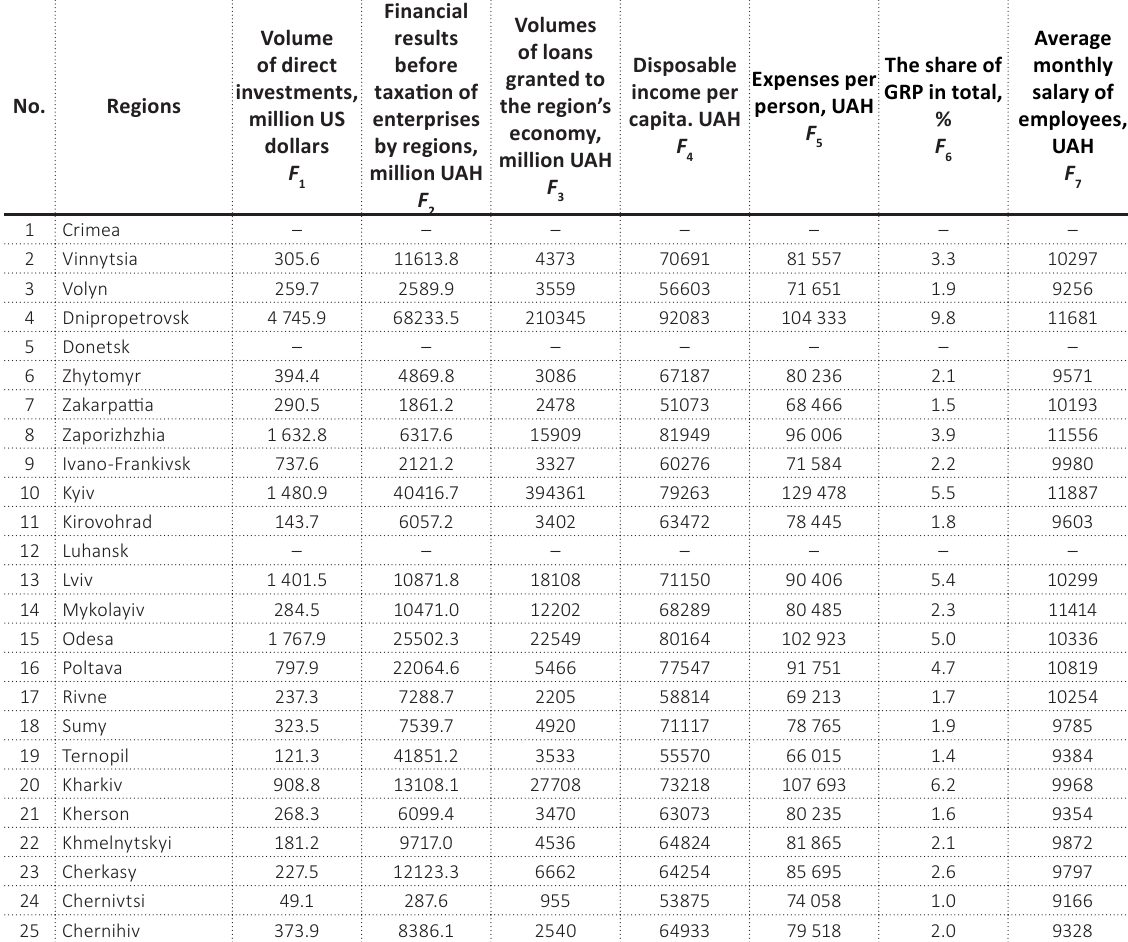
Table C1. Indicators of the provision of Ukraine’s regions with financial resources in 2020